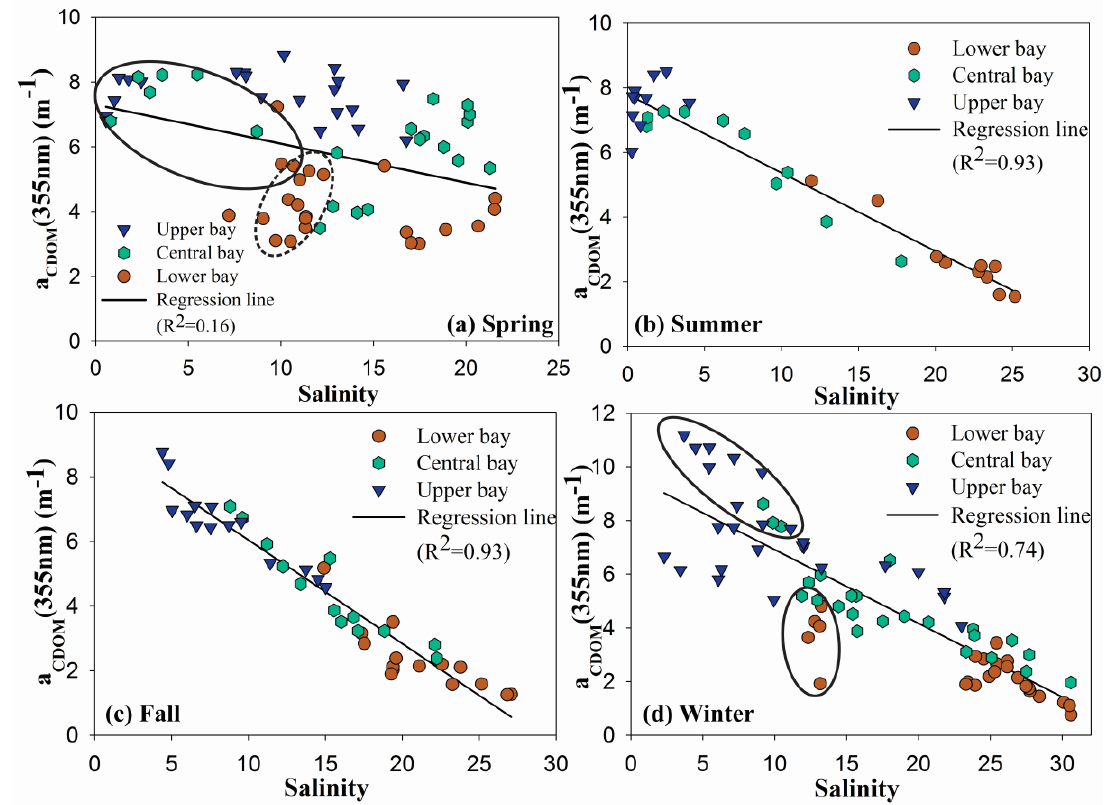
Figure 4. CDOM absorption coefficient (355nm) vs. salinity in ( a ) spring (the solid ellipse encloses measurements on 1 June 2010 associated with freshwater release at DPFD; the dashed ellipse encloses measurements at the marine stations on 6 April and 24 May 2011 associated with MR flood water), ( b ) summer, ( c ) fall, and ( d ) winter (solid ellipses correspond to measurements in Barataria Bay on 23 February 2010 associated with a high- pressure system (e.g., cold